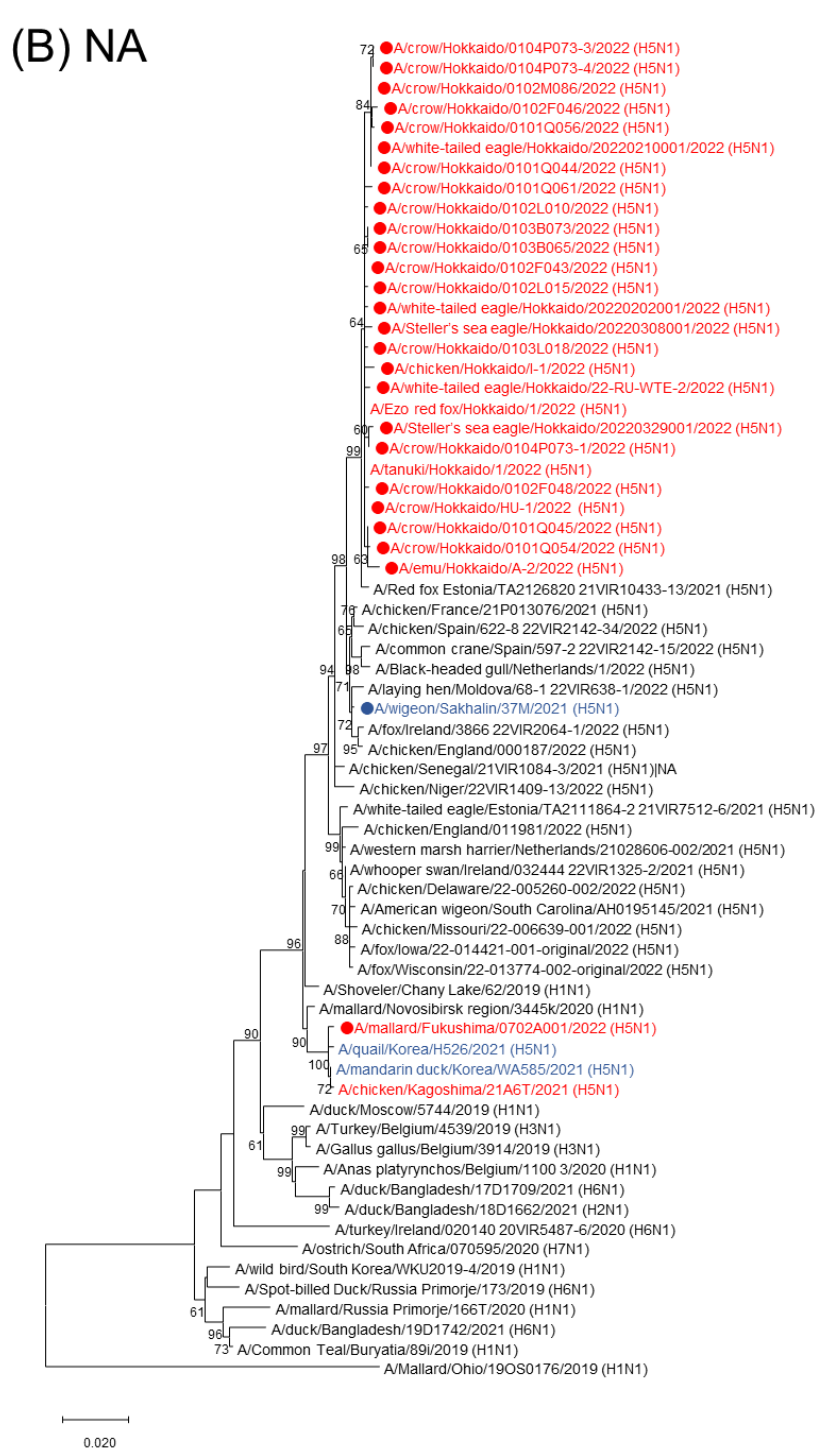
Figure 2. Phylogenetic tree analysis on the hemagglutinin (HA) and neuraminidase (NA) gene segment. Sequence data of the HA ( A ) and NA ( B ) genes of the viruses detected or isolated in this study and H5HA ( A ) and N1NA ( B ) viruses obtained from the Global Initiative on Sharing Avian Influenza Data database were used for constructing the phylogenetic tree. The red-colored strain indicates H5 HPAIVs detected or isolated in Japan in winter 2021–2022. The blue-colored strain indicates H5 HPAIVs isolated in the Republic of Korea or Sakhalin in the same season. The strain with a filled circle indicates the virus detected or isolated in this study. The numbers below or above the node indicate bootstrap values of